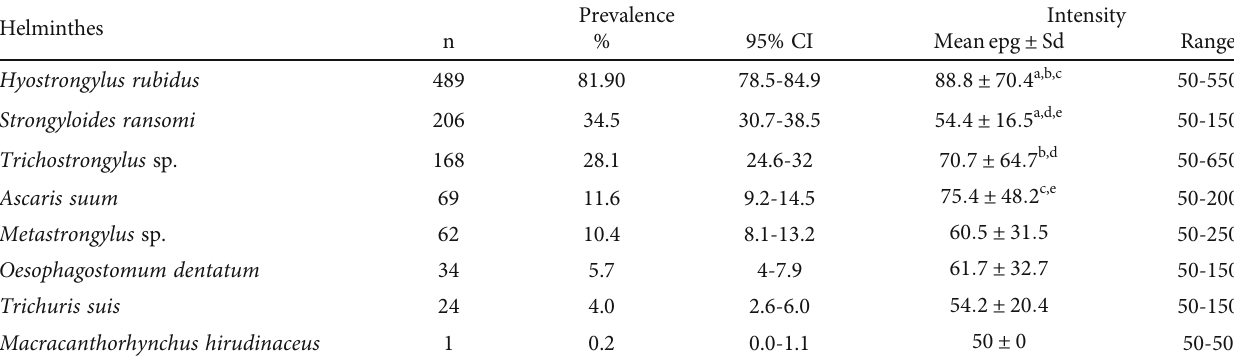
Table 1: Prevalence (%) and intensity of helminthes in pigs ( N = 597 ) in Menoua. Helminthes